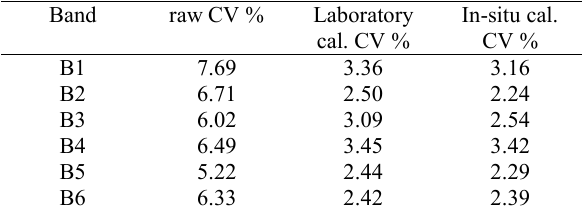
Table 3. Coefficients of variation at selected profile.